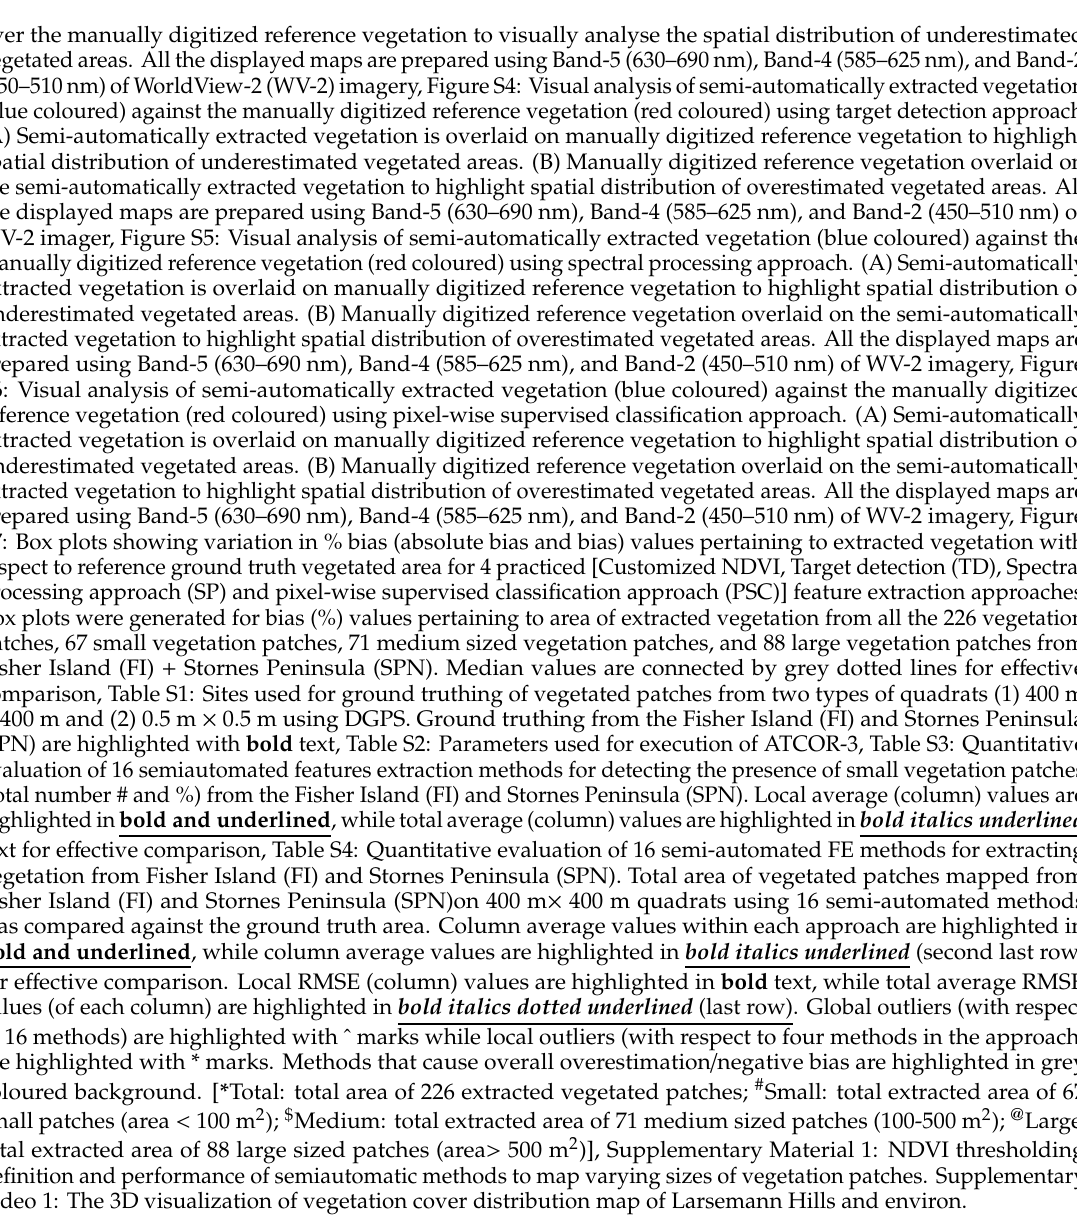
over the manually digitized reference vegetation to visually analyse the spatial distribution of underestimated vegetated areas. All the displayed maps are prepared using Band-5 (630–690 nm), Band-4 (585–625 nm), and Band-2 (450–510 nm) of WorldView-2 (WV-2) imagery, Figure S4: Visual analysis of semi-automatically extracted vegetation (blue coloured) against the manually digitized reference vegetation (red coloured) using target detection approach. (A) Semi-automatically extracted vegetation is overlaid on manually digitized reference vegetation to highlight spatial distribution of underestimated vegetated areas. (B) Manually digitized reference vegetation overlaid on the semi-automatically extracted vegetation to highlight spatial distribution of overestimated vegetated areas. All the displayed maps are prepared using Band-5 (630–690 nm), Band-4 (585–625 nm), and Band-2 (450–510 nm) of WV-2 imager, Figure S5: Visual analysis of semi-automatically extracted vegetation (blue coloured) against the manually digitized reference vegetation (red coloured) using spectral processing approach. (A) Semi-automatically extracted vegetation is overlaid on manually digitized reference vegetation to highlight spatial distribution of underestimated vegetated areas. (B) Manually digitized reference vegetation overlaid on the semi-automatically extracted vegetation to highlight spatial distribution of overestimated vegetated areas. All the displayed maps are prepared using Band-5 (630–690 nm), Band-4 (585–625 nm), and Band-2 (450–510 nm) of WV-2 imagery, Figure S6: Visual analysis of semi-automatically extracted vegetation (blue coloured) against the manually digitized reference vegetation (red coloured) using pixel-wise supervised classification approach. (A) Semi-automatically extracted vegetation is overlaid on manually digitized reference vegetation to highlight spatial distribution of underestimated vegetated areas. (B) Manually digitized reference vegetation overlaid on the semi-automatically extracted vegetation to highlight spatial distribution of overestimated vegetated areas. All the displayed maps are prepared using Band-5 (630–690 nm), Band-4 (585–625 nm), and Band-2 (450–510 nm) of WV-2 imagery, Figure S7: Box plots showing variation in % bias (absolute bias and bias) values pertaining to extracted vegetation with respect to reference ground truth vegetated area for 4 practiced [Customized NDVI, Target detection (TD), Spectral processing approach (SP) and pixel-wise supervised classification approach (PSC)] feature extraction approaches. Box plots were generated for bias (%) values pertaining to area of extracted vegetation from all the 226 vegetation patches, 67 small vegetation patches, 71 medium sized vegetation patches, and 88 large vegetation patches from Fisher Island (FI) + Stornes Peninsula (SPN). Median values are connected by grey dotted lines for e ff ective comparison, Table S1: Sites used for ground truthing of vegetated patches from two types of quadrats (1) 400 m × 400 m and (2) 0.5 m × 0.5 m using DGPS. Ground truthing from the Fisher Island (FI) and Stornes Peninsula (SPN) are highlighted with bold text, Table S2: Parameters used for execution of ATCOR-3, Table S3: Quantitative evaluation of 16 semiautomated features extraction methods for detecting the presence of small vegetation patches (total number # and %) from the Fisher Island (FI) and Stornes Peninsula (SPN). Local average (column) values are highlighted in bold and underlined , while total average (column) values are highlighted in bold italics underlined text for e ff ective comparison, Table S4: Quantitative evaluation of 16 semi-automated FE methods for extracting vegetation from Fisher Island (FI) and Stornes Peninsula (SPN). Total area of vegetated patches mapped from Fisher Island (FI) and Stornes Peninsula (SPN)on 400 m × 400 m quadrats using 16 semi-automated methods was compared against the ground truth area. Column average values within each approach are highlighted in bold and underlined , while column average values are highlighted in bold italics underlined (second last row) for e ff ective comparison. Local RMSE (column) values are highlighted in bold text, while total average RMSE values (of each column) are highlighted in bold italics dotted underlined (last row). Global outliers (with respect to 16 methods) are highlighted with ˆ marks while local outliers (with respect to four methods in the approach) are highlighted with * marks. Methods that cause overall overestimation / negative bias are highlighted in grey coloured background. [ * Total: total area of 226 extracted vegetated patches; # Small: total extracted area of 67 small patches (area < 100 m 2 ); $ Medium: total extracted area of 71 medium sized patches (100-500 m 2 ); @ Large: total extracted area of 88 large sized patches (area > 500 m 2 )], Supplementary Material 1: NDVI thresholding definition and performance of semiautomatic methods to map varying sizes of vegetation patches.